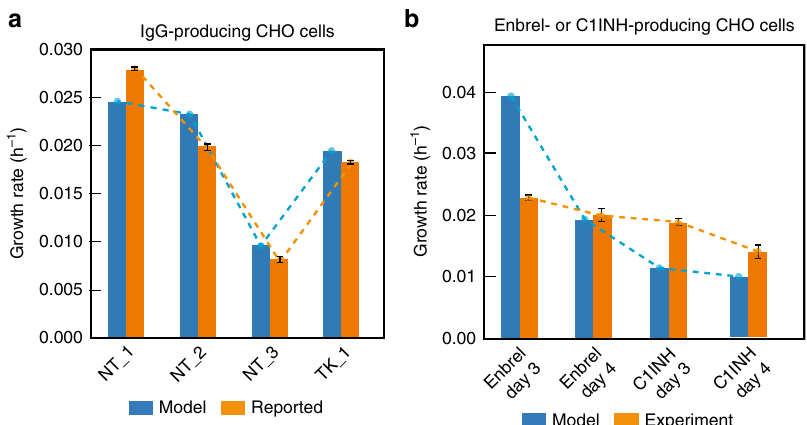
Fig. 3 Recombinant protein-producing models of iCHO2048s predict measured growth rates. a Growth rates were computed using an IgG-speci fi c iCHO2048s model and compared to experimentally measured growth rates from six datasets from two previous studies using IgG-producing cell lines 12,18 . NT and TK specify the initials of the fi rst author of the two studies (Neil Templeton, Thomas Kallehauge). b Additional growth, productivity, and metabolomic data were obtained from Enbrel and C1INH-producing CHO cells, and models were constructed. The model-predicted growth rates during exponential growth phase were consistent with experimental growth rates of Enbrel-producing CHO cells and C1INH-producing CHO cells at almost all time points. In all cases, the iCHO2048s models were constrained to produce the recombinant protein at the measured speci fi c productivity rate. The values used to constrain each of the iCHO2048s models are reported in Supplementary Data 3. Error bars represent the standard deviation of three biological replicates. Source data are provided as a Source Data fi le.